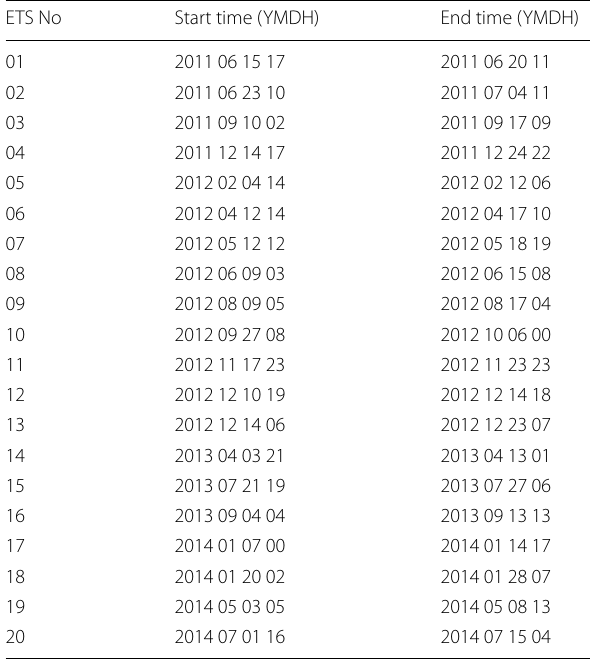
Table 1 Duration of each ETS event for semblance analysis